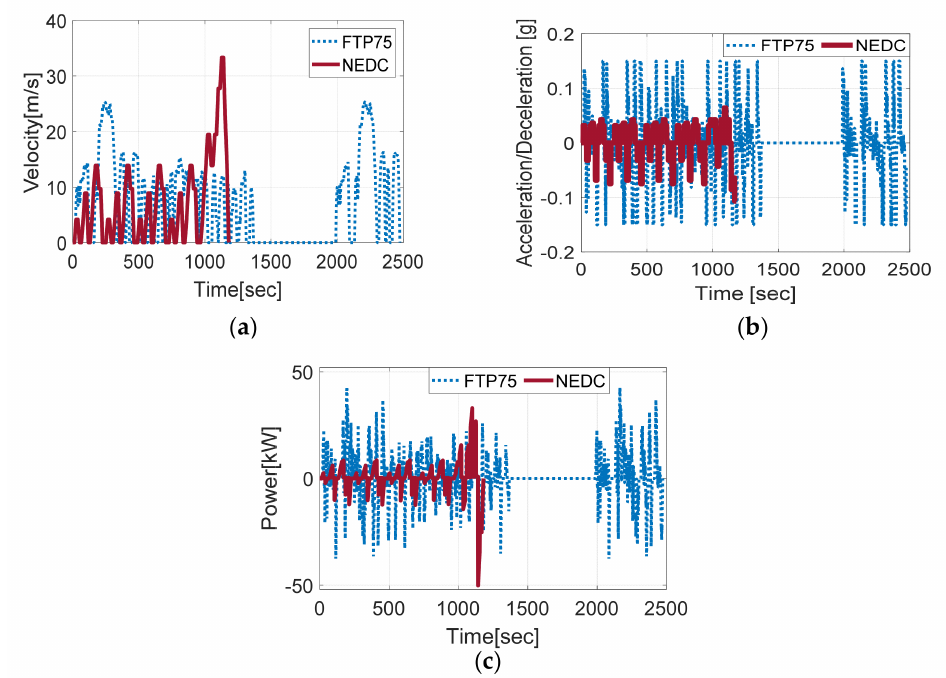
Figure 5. Characteristic profiles of the velocity ( a ), acceleration/deceleration ( b ), and power requirements ( c ) of the FTP75 and